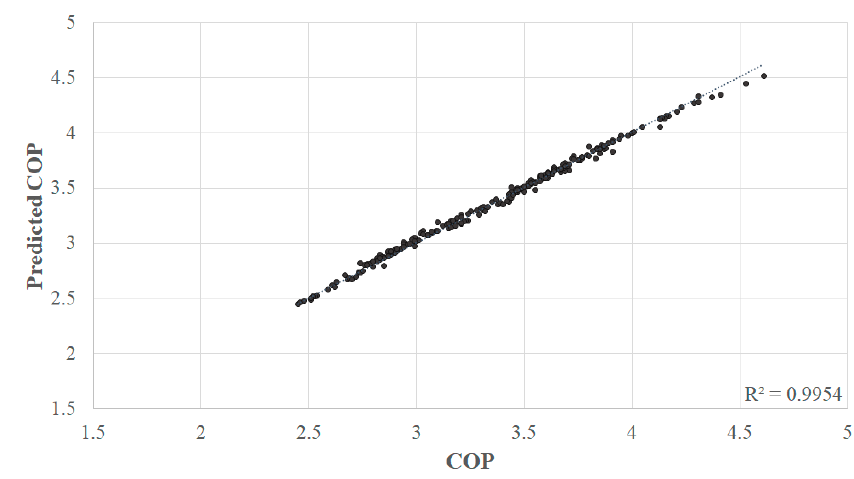
Figure 11. Comparison of predicted and measured performance.